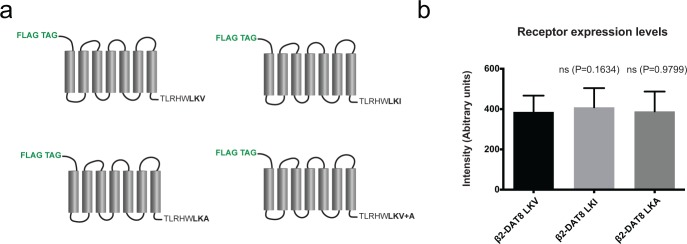
β2 fusion constructs and expression levels.(a) Schematic representation of β2 C-terminal fusion constructs. (b) Expression levels of β2 DAT fusion constructs. Secondary units are arbitrary units relating to measured intensities.